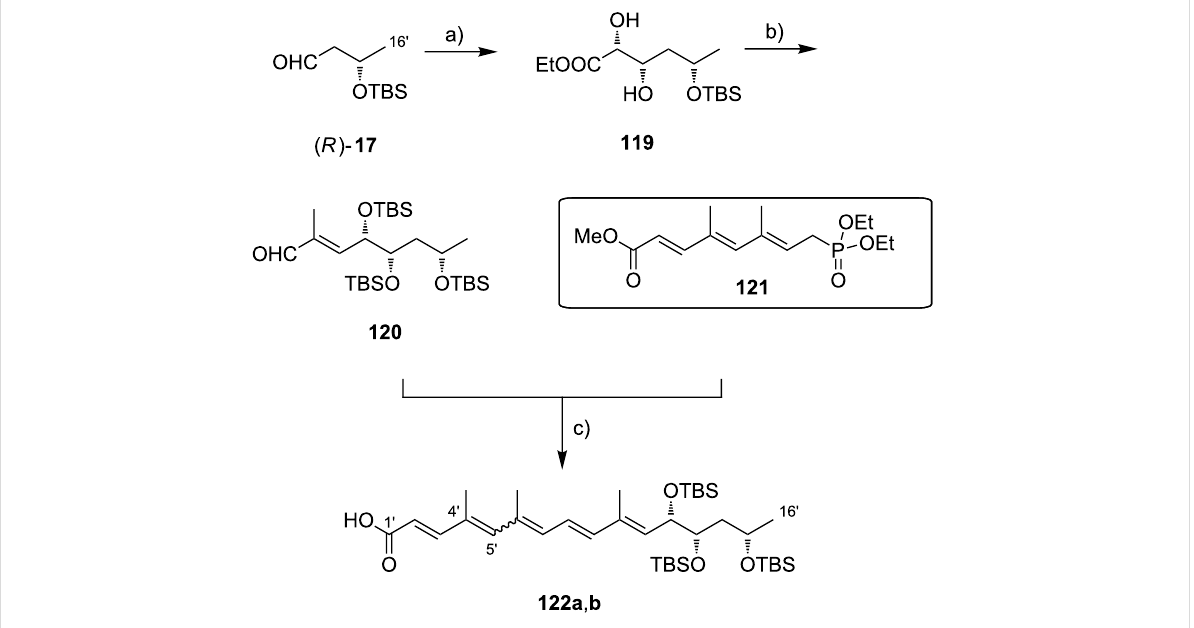
Scheme 15: Kishi’s synthesis of the mycolactone A/B pentaenoate side chain. (a) (i) NaH, (EtO) 2 P(O)CH 2 CO 2 Et, THF, rt, 64%; (ii) AD-mix- α , MeSO 2 NH 2 , 1:1 t -BuOH/H 2 O, 0 °C, 70%, dr 3.8:1; (b) (i) TBSOTf, 2,6-lutidine, CH 2 Cl 2 , 0 °C, 99%; (ii) DIBAL-H, CH 2 Cl 2 , − 78 °C, 89%; (iii) SO 3 ·pyri- dine, DIPEA, 3:2 CH 2 Cl 2 /DMSO, rt; (iv) Ph 3 P=C(Me)CO 2 Et, toluene, 110 °C, 83% (2 steps); (v) DIBAL-H, CH 2 Cl 2 , − 78 °C, then separation of dia- stereomers by flash chromatography; major isomer: 57%; minor isomer: 15%; (vi) SO 3 ·pyridine, DIPEA, 3:2 CH 2 Cl 2 /DMSO, rt, quant.; c) (i) LDA, THF, − 78 °C to rt, 94% ( E - Δ 4’,5’ / Z - Δ 4’,5’ /other isomers 73:17:10); (e) LiOH, THF/MeOH/H 2 O 4:1:1, rt, quant. ( Z - Δ 4’,5’ / E - Δ 4’,5’ 3:2 + minor isomers).